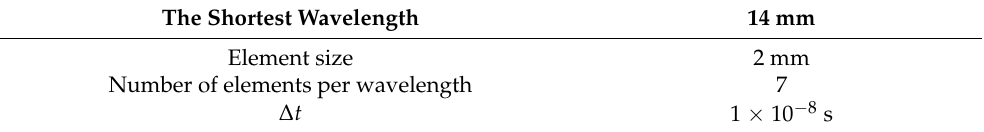
Table 2. Mesh partition